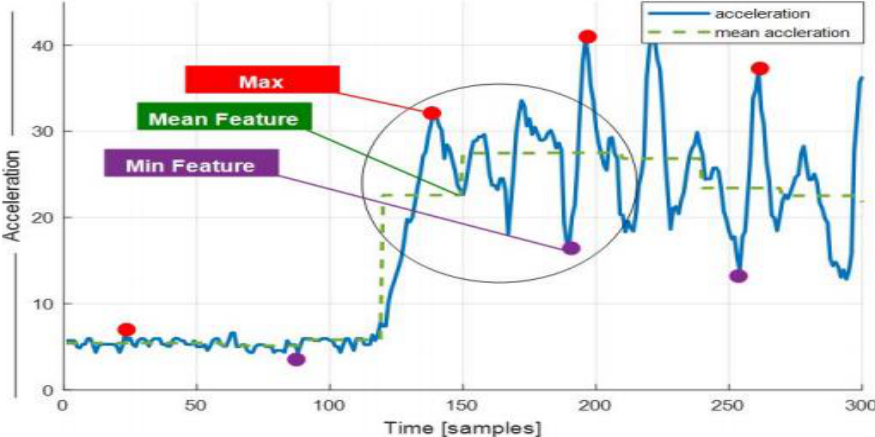
Figure6. Thethreestatisticalfeatures(mean, min, max)forpracticingimitationinthe“climbing upstairs” Figure 6. The three statistical features (mean, min, max) for practicing imitation in the “climbing motion pattern using the Wireless Sensor Data Mining (WISDM) upstairs” motion pattern using the Wireless Sensor Data Mining (WISDM) dataset.